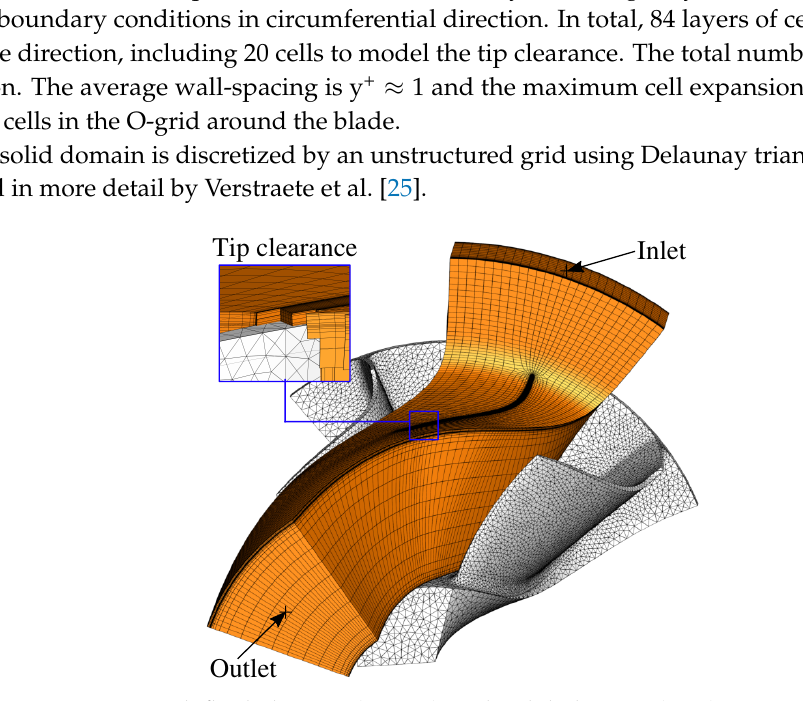
Figure 1. Discretized fluid domain (orange) and solid domain (grey). Coarse meshes for better